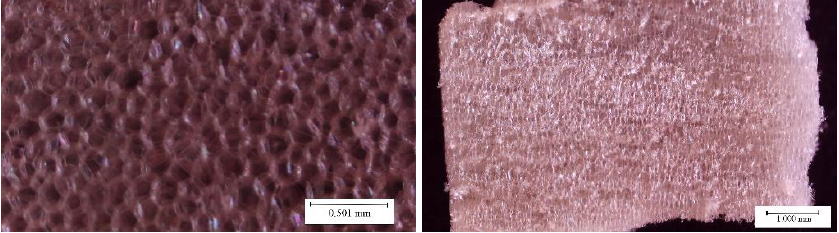
Fig. 1. Cross-section and longitudinal section of a DSNP sample on an optical